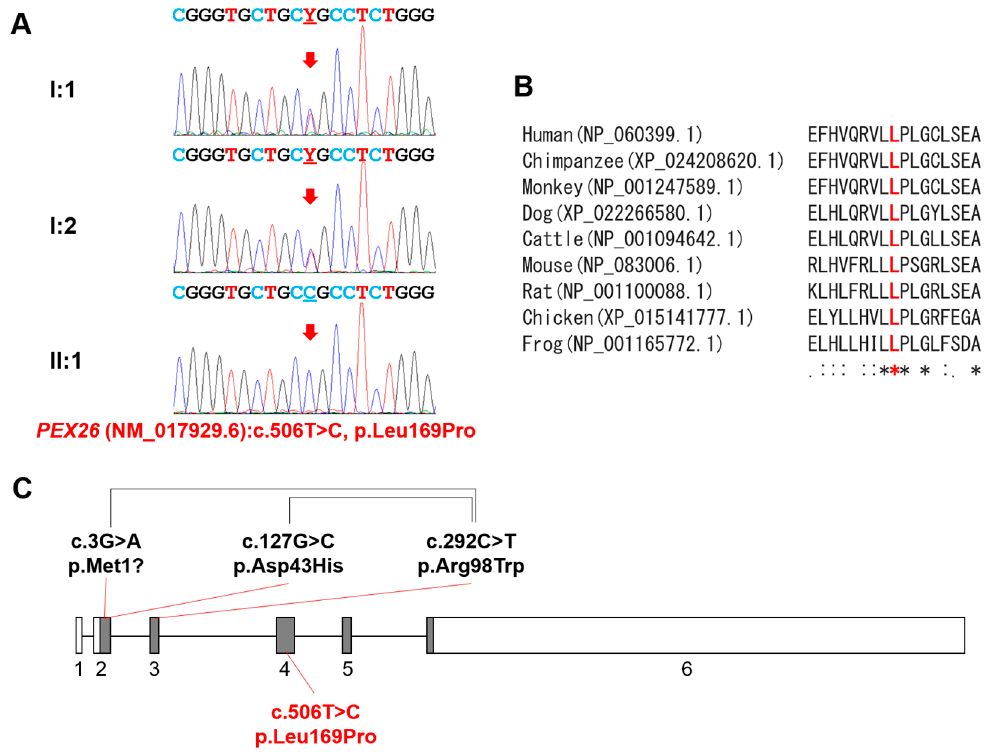
Figure 2. Sequencing chromatograms, homology, and gene diagram. ( A ) Sequencing chromatograms of the family members. Individual IDs are indicated on the left of each chromatogram. Nucleotide sequences are shown above the chromatograms. The mutated nucleotide is indicated by a red arrow and underlined. Y denotes mixed nucleotides of T and C. ( B ) Homology among vertebrates. Mutated amino acid is indicated by the bold and red character. Asterisks under the sequences indicate perfectly conserved amino acid positions. ( C ) Gene diagram of the PEX26 gene (NM_017929.6). Boxes indicate the exons, and the exon numbers are shown below the boxes. Gray areas in the box indicate coding regions, and white areas indicate untranslated regions. Mutations above the diagram are previously reported compound heterozygous mutations, and paired mutations are connected with black connecting lines. The homozygous mutation identified in this study is shown below the diagram.